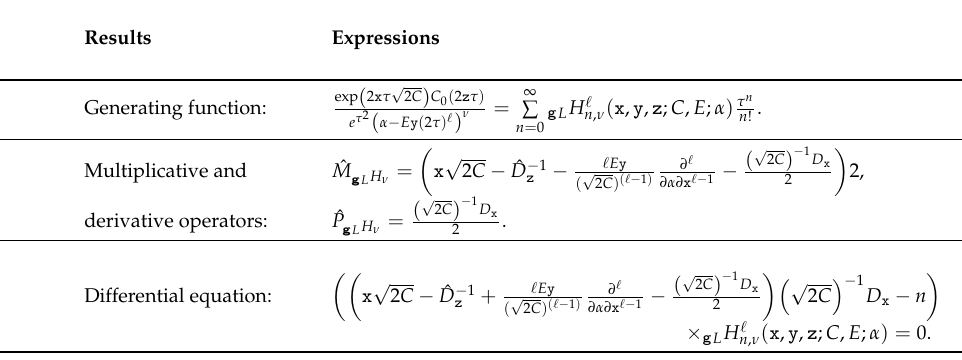
Table 4. Results for the EGHLHMaP g L H (cid:96) n , ν ( x , y , z ; C , E ; α ) . Results